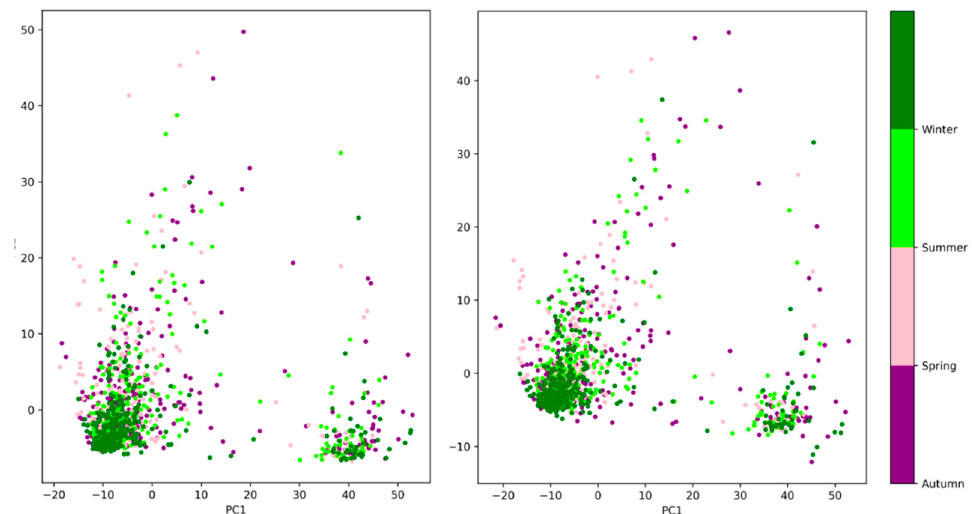
Figure 6. Scatter plot of the two PC of the Gram matrices of the first convolutional layer (on the left) and of the second (on the right), where each point is a drawing.